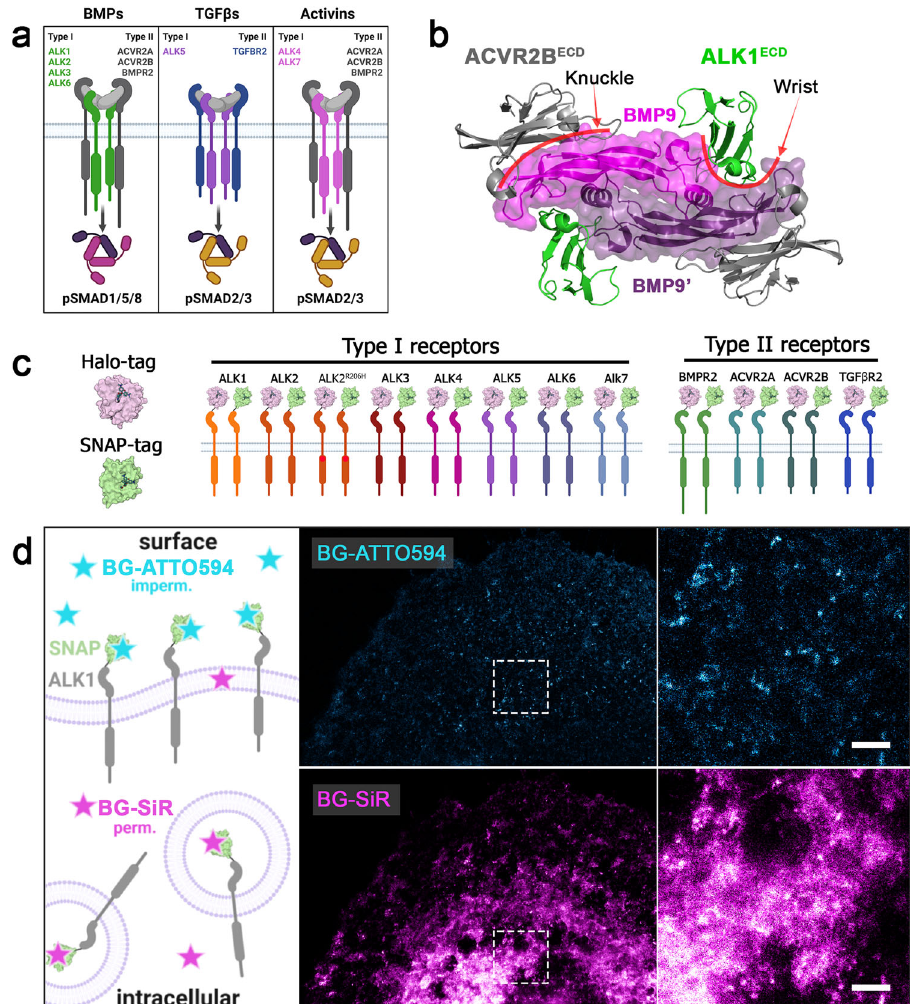
Fig. 1 Halo- and SNAP-tagged BMP and TGF β receptors can be visualized covalently and fast with organic fl uorophore-labeled substrates allowing the discrimination between surface and intracellular receptor populations. a Overview of preferential receptor-ligand paring. b Top view of the extracellular domains of ALK1 and ACVR2B in a heterotetrameric receptor complex bound to BMP9 (crystal structure PDB: 4FAO). Type l receptor ALK1 binds at the wrist interface, type II receptor ACVR2B binds at the knuckle interface of BMP9, respectively. c Schematic of N-terminally Halo- and SNAP-tagged BMP and TGF β receptor library consisting of type I receptors (ALK1-ALK7 and FOP-mutant ALK2-R206H) and type II receptors (BMPR2, ACVR2A, ACVR2B, and TGFBR2). d Discrimination between surface and cytosolic receptor populations. COS-7 cells transiently expressing ALK1-SNAP were 24 h post- transfection incubated with BG-ATTO594 (impermeable; cyan) and chased by BG-SiR (permeable; magenta) allowing for staining of the surface receptor population and the cytosolic receptor population, respectively. BG benzyl guanine, SiR silicon